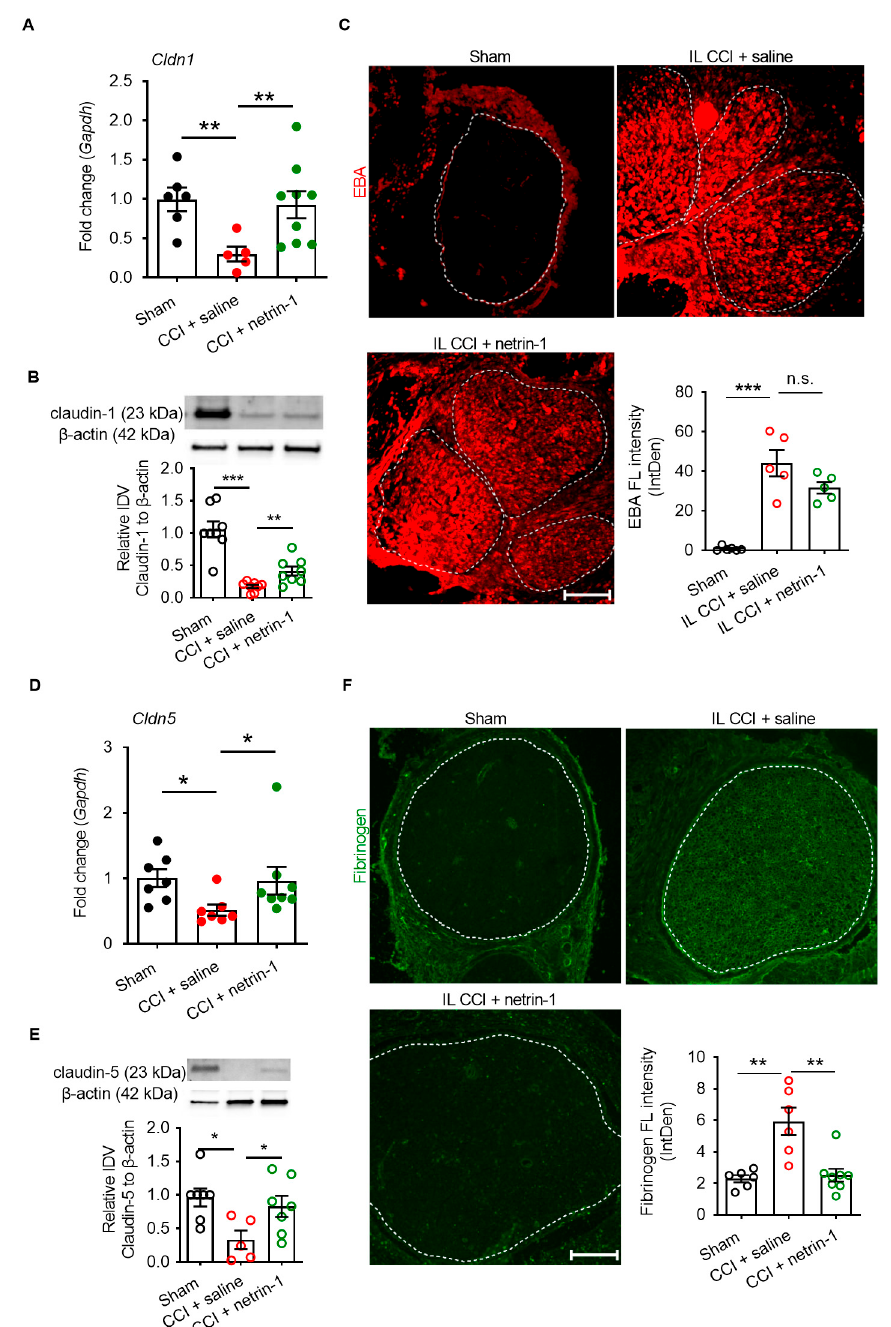
Figure 4. Exogenous netrin-1 stabilizes the BNB after CCI. Wister rats underwent CCI and were treated with daily i.p. netrin-1 injection. ( A , B , D , E ) Tight junction protein mRNA and protein expression of Cldn1 and Cldn5 sciatic nerves were quantified (IDV: integrated density value). Gapdh was used as a housekeeping gene for normalization of gene expression experiments, and β -actin for protein analysis experiments. ( C ) Evans blue albumin dye signal (red) was measured after ex vivo immersion of sciatic nerves and subsequently quantified in the endoneurium. If more than one fascicle was present, the mean was calculated (FL: fluorescence; IntDen: integrated density). ( F ) Endoneurial fibrinogen immunoreactivity (green) was analyzed in control and injured sciatic nerves ( n = 5–7). Dotted lines delineate the endoneurium and area of quantification. All mean ± SEM, n = 5–7, Mann–Whitney U test, * p < 0.05, ** p < 0.01, *** p < 0.001, n.s.: not significant. Scale bars: 100 μ m.